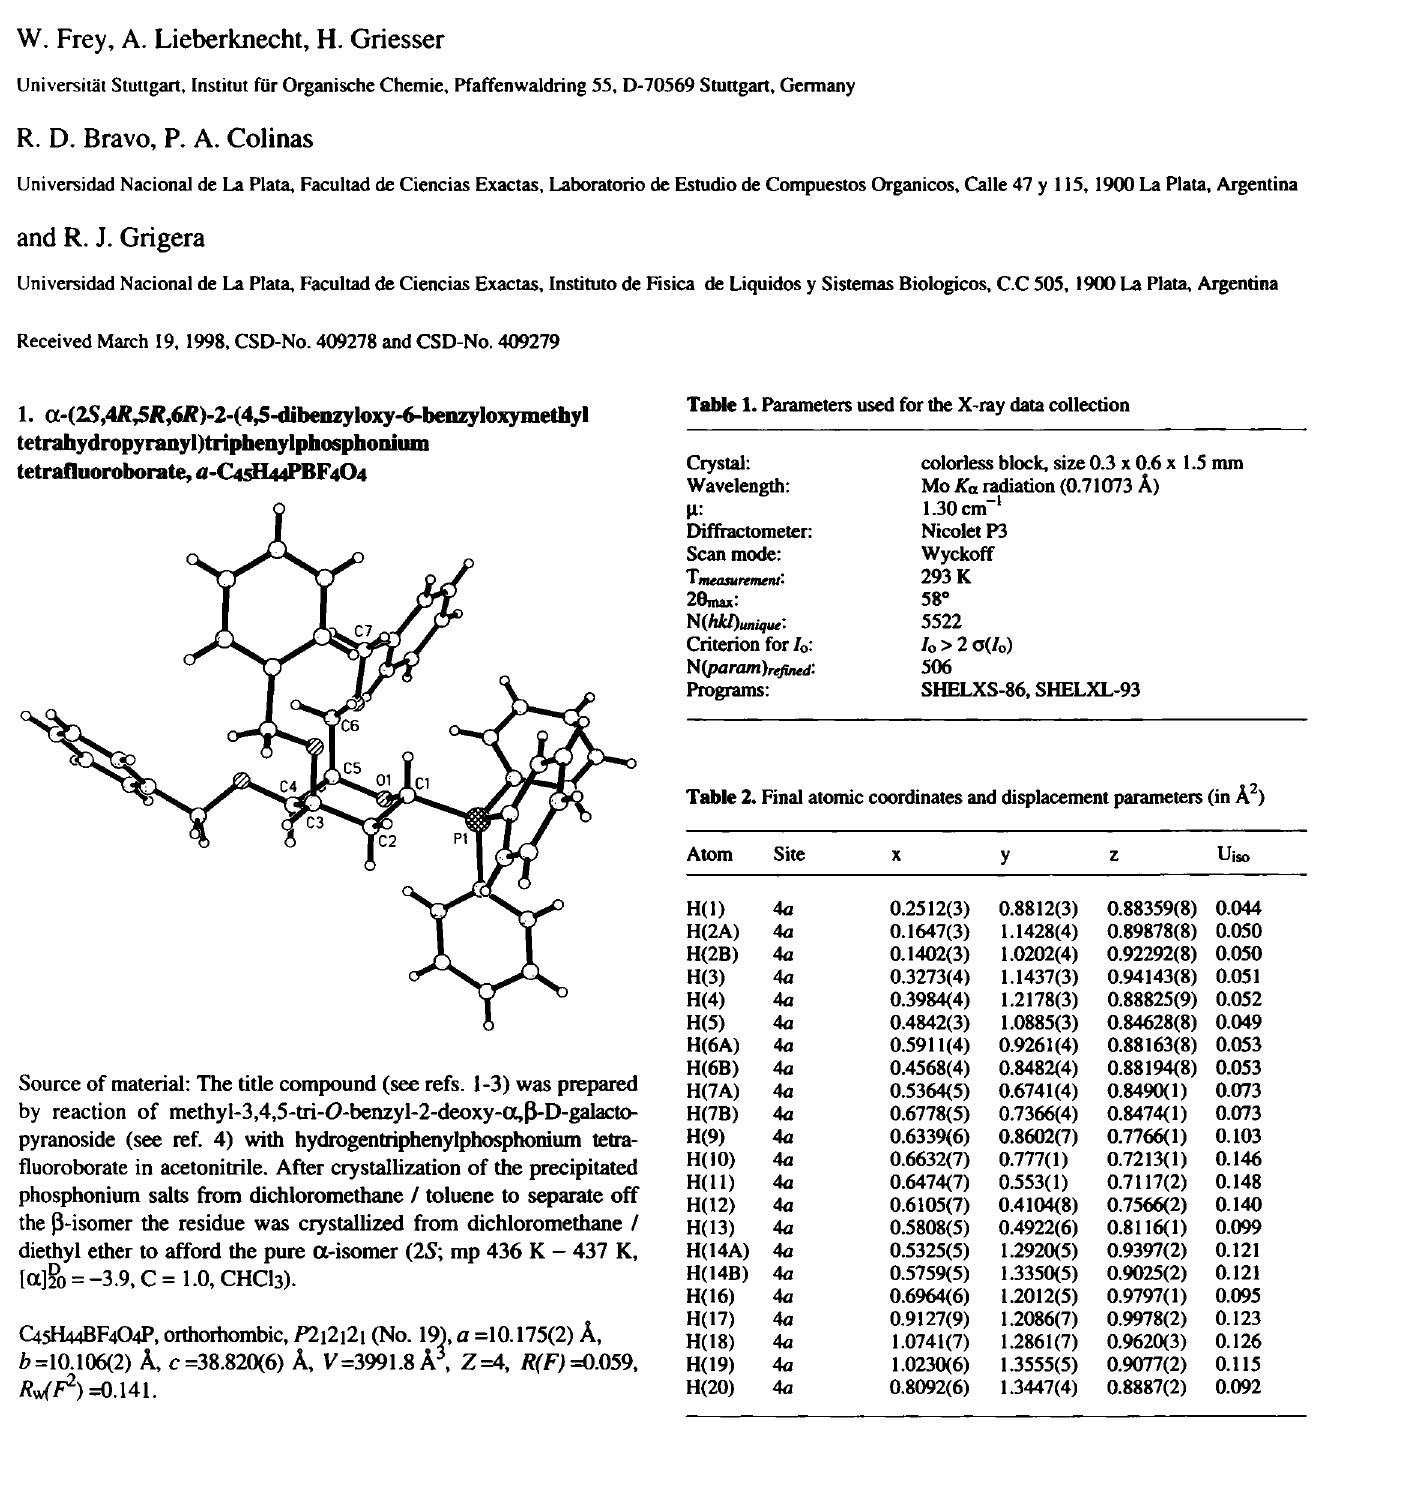
Table 1. Parameters used for the X-ray data collection